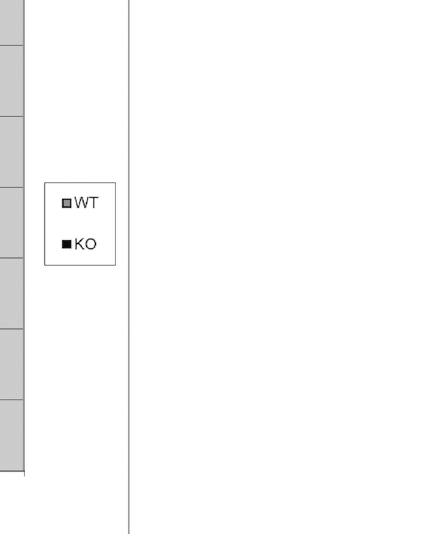
PLOS ONE | DOI:10.1371/journal.pone.0131981 July 6,